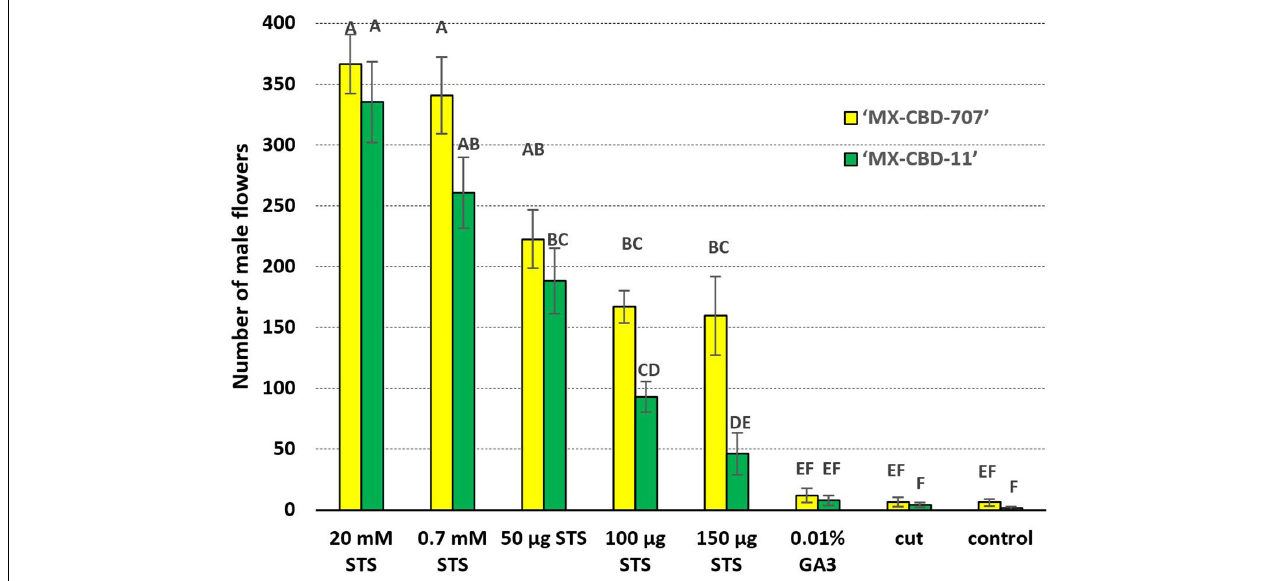
FIGURE 2 | The number of induced male flowers per plant is indicated by the interaction effect between breeding population and treatment. Mean values followed by different letters are significantly different at the 5% level of probability (Tukey). Horizontal bars represent SE ( ± SE).